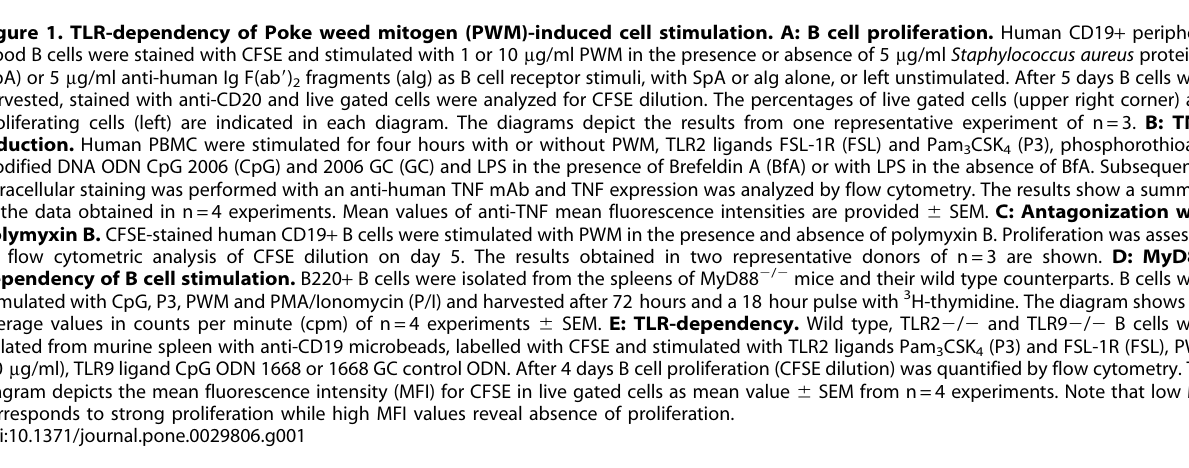
Figure 1. TLR-dependency of Poke weed mitogen (PWM)-induced cell stimulation. A: B cell proliferation. Human CD19 + peripheral blood B cells were stained with CFSE and stimulated with 1 or 10 m g/ml PWM in the presence or absence of 5 m g/ml Staphylococcus aureus protein A (SpA) or 5 m g/ml anti-human Ig F(ab 9 ) 2 fragments (aIg) as B cell receptor stimuli, with SpA or aIg alone, or left unstimulated. After 5 days B cells were harvested, stained with anti-CD20 and live gated cells were analyzed for CFSE dilution. The percentages of live gated cells (upper right corner) and proliferating cells (left) are indicated in each diagram. The diagrams depict the results from one representative experiment of n=3. B: TNF- induction. Human PBMC were stimulated for four hours with or without PWM, TLR2 ligands FSL-1R (FSL) and Pam 3 CSK 4 (P3), phosphorothioate- modified DNA ODN CpG 2006 (CpG) and 2006 GC (GC) and LPS in the presence of Brefeldin A (BfA) or with LPS in the absence of BfA. Subsequently, intracellular staining was performed with an anti-human TNF mAb and TNF expression was analyzed by flow cytometry. The results show a summary of the data obtained in n=4 experiments. Mean values of anti-TNF mean fluorescence intensities are provided 6 SEM. C: Antagonization with Polymyxin B. CFSE-stained human CD19 + B cells were stimulated with PWM in the presence and absence of polymyxin B. Proliferation was assessed by flow cytometric analysis of CFSE dilution on day 5. The results obtained in two representative donors of n=3 are shown. D: MyD88- dependency of B cell stimulation. B220 + B cells were isolated from the spleens of MyD88 2 / 2 mice and their wild type counterparts. B cells were stimulated with CpG, P3, PWM and PMA/Ionomycin (P/I) and harvested after 72 hours and a 18 hour pulse with 3 H-thymidine. The diagram shows the average values in counts per minute (cpm) of n=4 experiments 6 SEM. E: TLR-dependency. Wild type, TLR2 2 / 2 and TLR9 2 / 2 B cells were isolated from murine spleen with anti-CD19 microbeads, labelled with CFSE and stimulated with TLR2 ligands Pam 3 CSK 4 (P3) and FSL-1R (FSL), PWM (10 m g/ml), TLR9 ligand CpG ODN 1668 or 1668 GC control ODN. After 4 days B cell proliferation (CFSE dilution) was quantified by flow cytometry. The diagram depicts the mean fluorescence intensity (MFI) for CFSE in live gated cells as mean value 6 SEM from n=4 experiments. Note that low MFI corresponds to strong proliferation while high MFI values reveal absence of